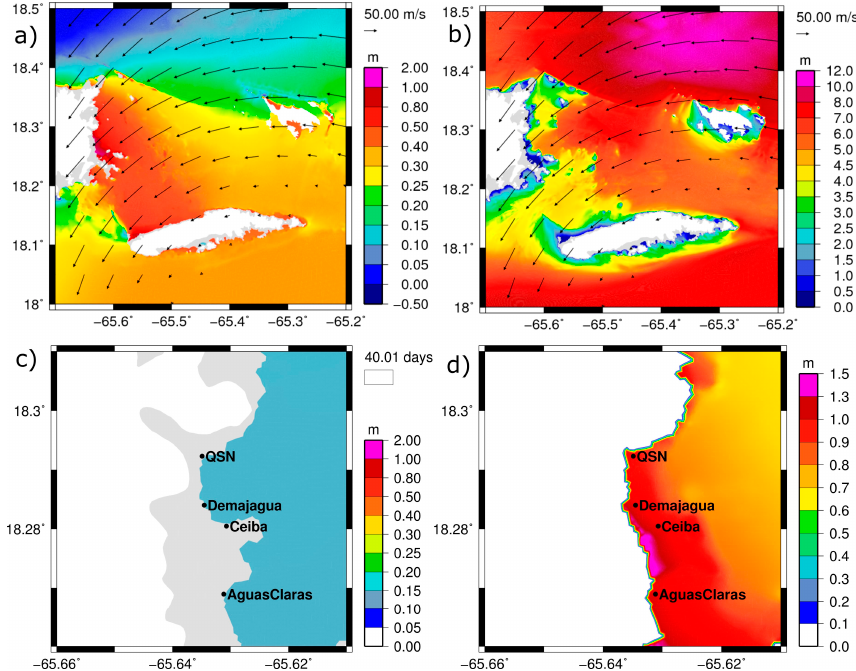
Figure 9. ( a ) Water surface elevation and ( b ) significant wave heights at the time of maximum wind speeds and most direct hit of winds to the eastern coast of Puerto Rico. ( c ) ADCIRC + SWAN water surface elevation before Hurricane Georges in the vicinity of the area of interest and ( d ) ADCIRC + SWAN maximum water surface elevation during Hurricane Georges. Water levels before Hurricane Georges are shown as a reference of the extent of the maximum storm surge and the labels in ( d ) outlets used in the ADCIRC + SWAN + GSSHA linking. The highest elevation is represented with magenta and the lowest elevation is represented with dark blue (including the dry inland nodes). The islands and territories are represented with the white and grey color. The river/tributary outlets are identified with their names as QSN, Ceiba, Demajagua and Aguas Claras.